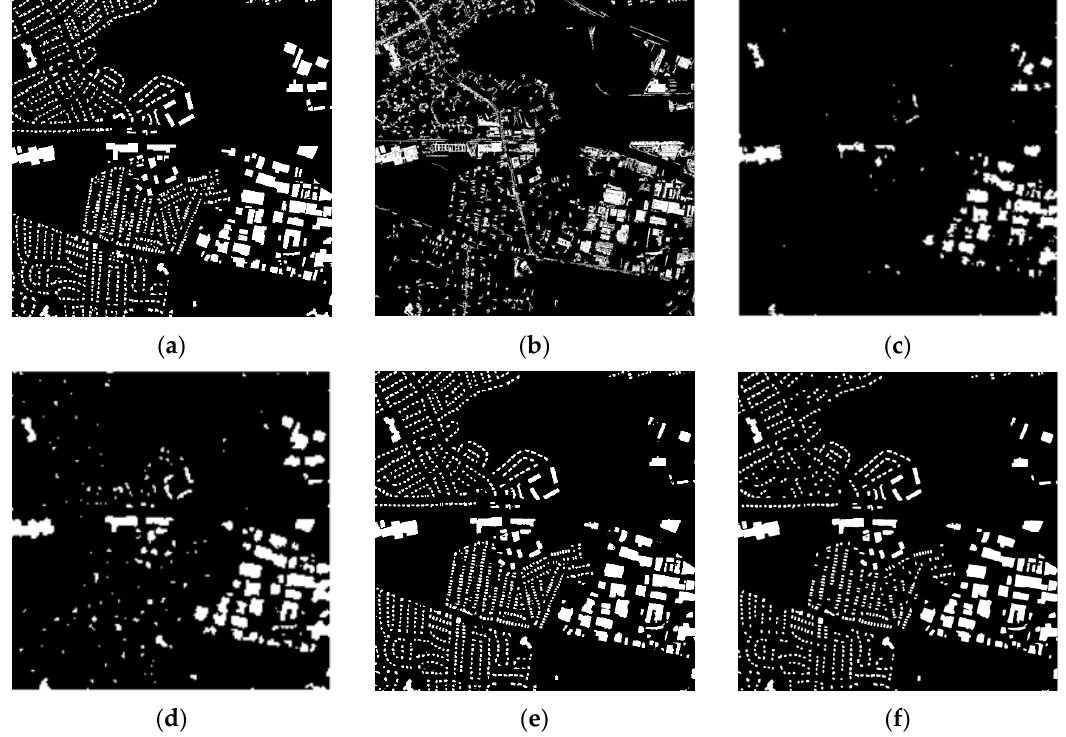
Figure 10. Building extraction results using the Massachusetts dataset. ( a ) Label; ( b ) DPSCRF; ( c ) FullCRF; ( d ) ConvCRF; ( e ) D-LinkNet; ( f ) MSCRF. Table 2. Quantitative evaluation of buildings extracted from the Massachusetts